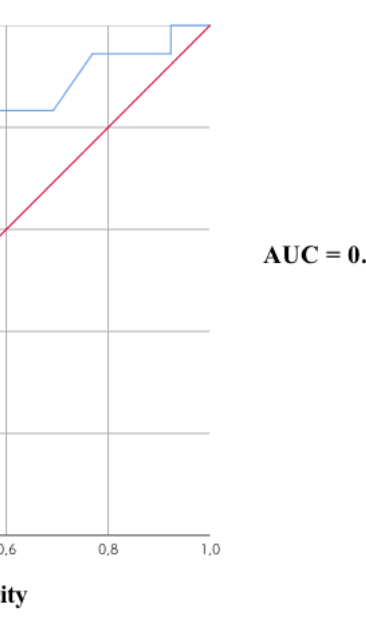
Figure 4. Predicting the membership of the second cluster on the basis of the T-scale scores. An ROC curve can be considered as the average value of the sensitivity for a test over all possible values of specificity or vice versa. A more general interpretation is that given the test results, the probability that for a randomly selected pair of patients with and without the disease/condition, the patient with the disease/condition has a result indicating greater suspicion. The area under the ROC (AUC) curve is bounded by the blue line and red baseline. The value of the AUC index is in the interval (0.1) delimited by two marked color lines. AUC, a high area under curve value limited by a blue line; ROC, a Receiver Operating Characteristic curve that includes all the possible decision thresholds from a diagnostic test result.